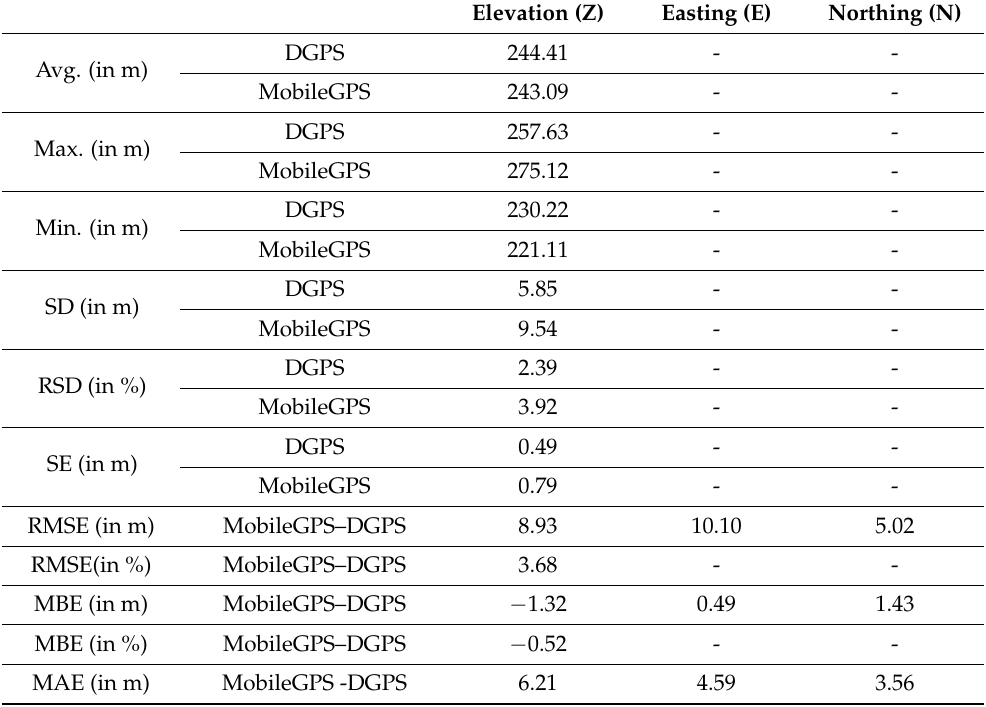
Table 3. The descriptive statistics and measures of differences between values obtained from the two ground-based devices (DGPS and MobileGPS) based on their positional estimates at the